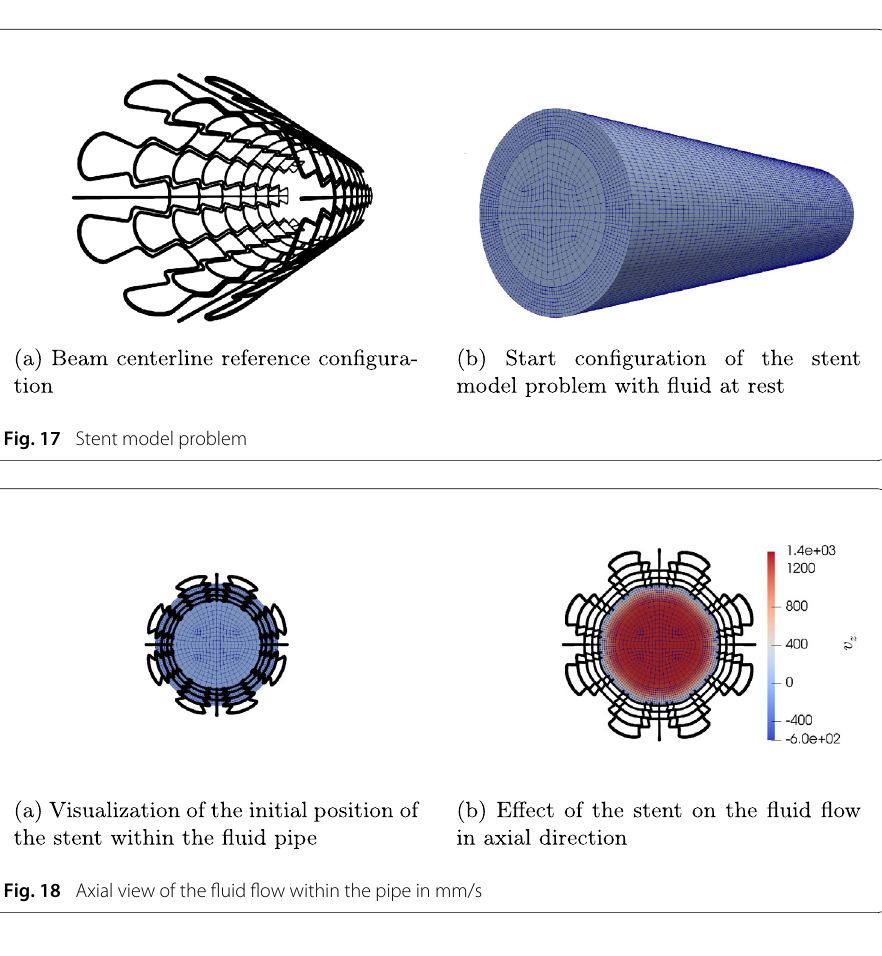
domain. Figure 18a shows the initial position of the stent at the edge of the outer fluid mesh